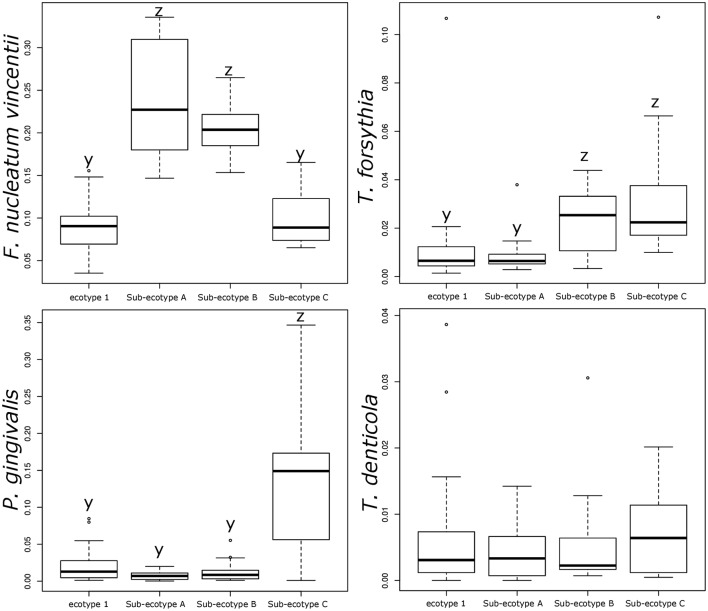
Relative abundance of the classical bacteria F. nucleatum vincentii, P. gingivalis, T. forsythia, and T. denticola associated with periodontitis. Bar plots showing the difference in relative abundance of the classical periodontitis pathogens between ecotype 1 and the three sub-ecotypes A, B, and C. Pairwise comparisons were tested using t-test or Wilcoxon test as appropriate with a Bonferroni correction. Mean with a different letter are significantly different (corrected p-value < 0.01).